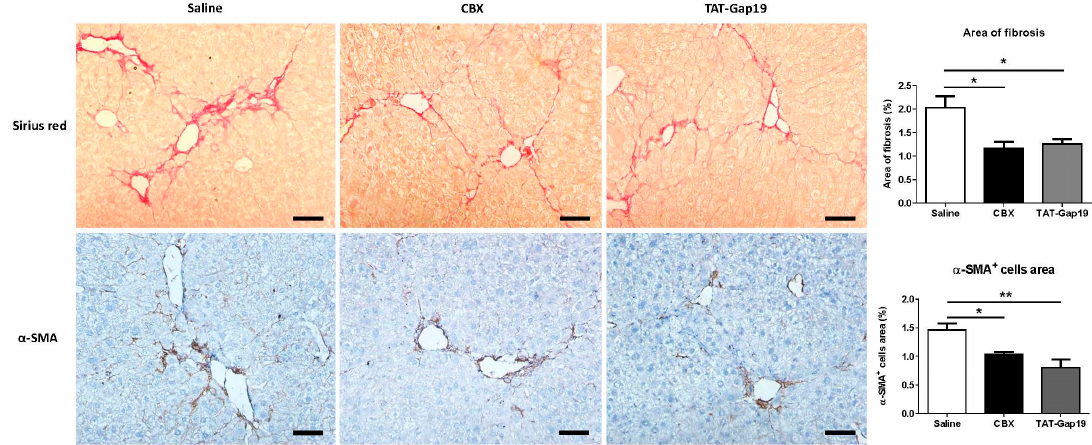
Figure 2. Effects of CBX and TAT-Gap19 on the fibrotic response after thioacetamide (TAA)-induced chronic hepatic injury in mice . Mice were administered TAA intraperitoneally for eight weeks. Initially, mice ( n = 5/group) were administered 100 mg TAA/kg body weight, followed by 10% weekly increments to the utmost dose of approximately 200 mg TAA/kg body weight. Thereafter, an osmotic pump was implanted in the peritoneal cavity, which ensured the release of 1 mg TAT-Gap19 or CBX/kg body weight/day or saline for two weeks. Collagen morphometric analysis was performed by the quantification of the area of collagen fibers stained by Sirius red. Hepatic stellate cells (HSC) activation was assessed through immunohistochemistry analysis of α -SMA-positive cells area. At least 10 randomly selected fields were quantified from the left lobe of each animal. Results were analyzed by 1-way ANOVA followed by post hoc Bonferroni correction. Data were expressed as means ± SEM (* p ≤ 0.05; ** p ≤ 0.01). Scale bar represents 50 µ m.